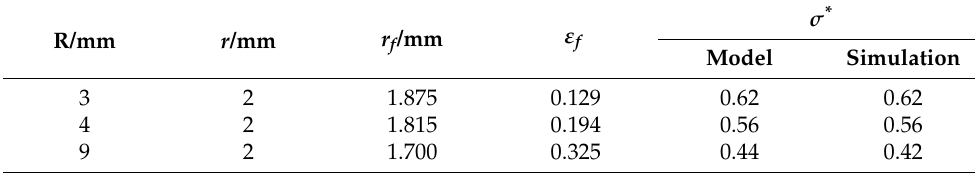
Table 3. Facture strain and stress triaxiality of specimens.